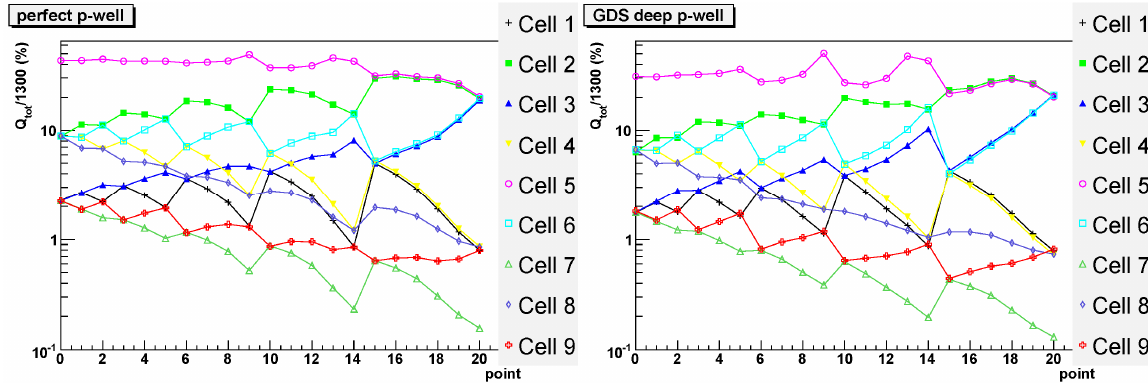
Figure 9. Simulation of charge collection for the (GDS) pixel layout data and an ideal (perfect) pixel containing only the collection diodes, as a function of the impact point and for the nine cells in the layout. On the left: with a perfect P-well. On the right: reference plot from Figure 8: standard pixel with deep